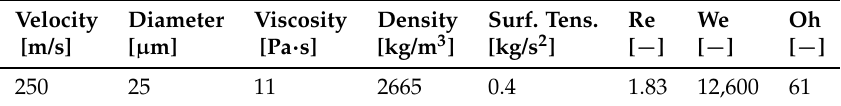
Table 3. Operating parameters for the reference